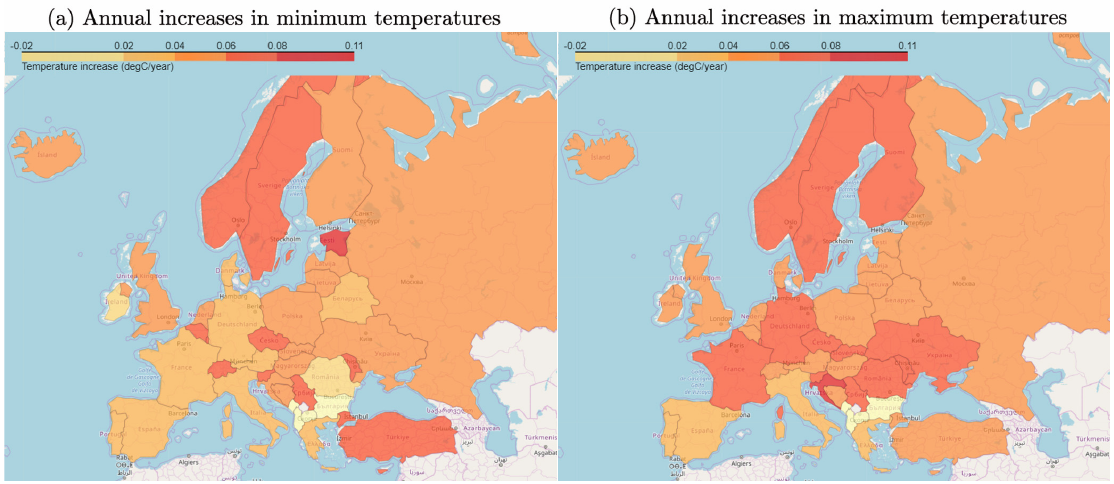
Figure 13. Annual increase of temperatures obtained from the trend component of the GAM for the ( a ) minimum and ( b ) maximum temperatures of the 37